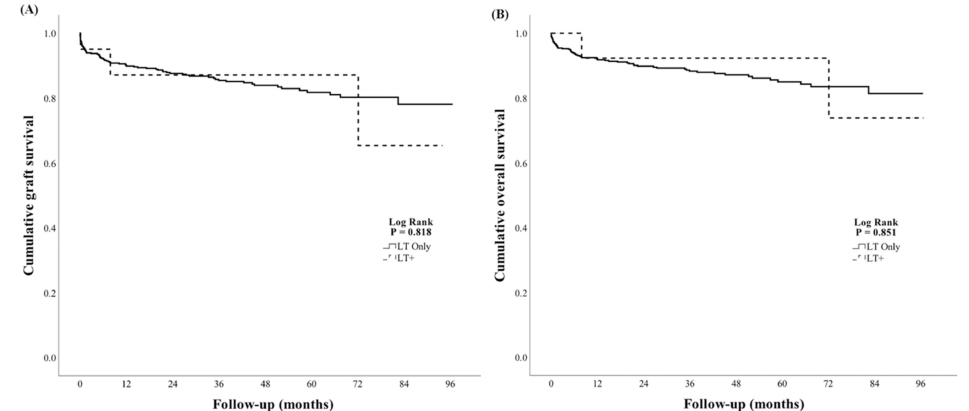
Figure 1. Survival analyses. Kaplan–Meier analyses of cumulative liver graft survival ( A ) and overall survival ( B ) in liver transplantation only (LT only) and liver transplantation with an additional operation (LT + )